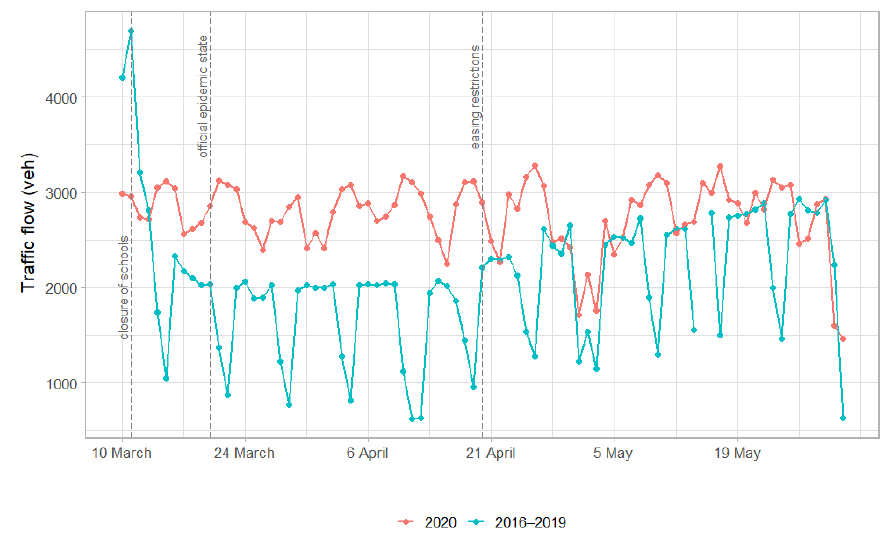
Figure 8. Average daily values of traffic flow. The average daily values of pollutants concentrations at individual